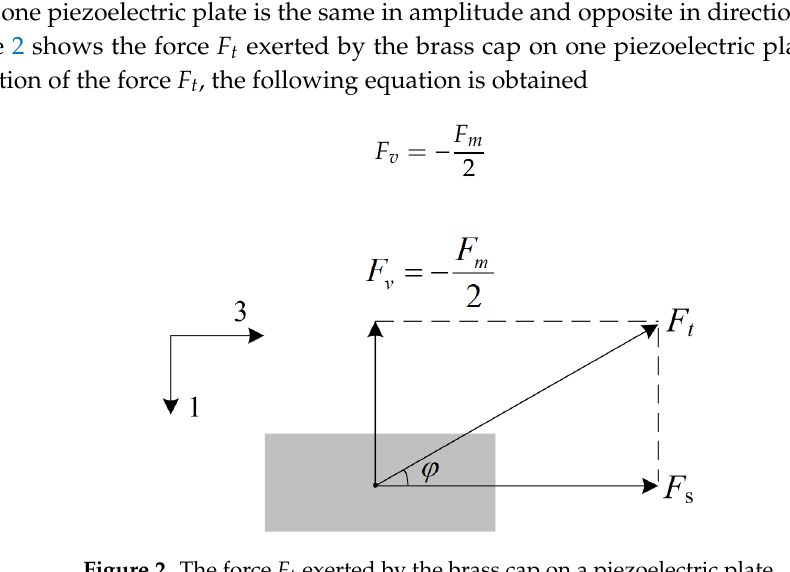
Figure 2. The force F t exerted by the brass cap on a piezoelectric plate.